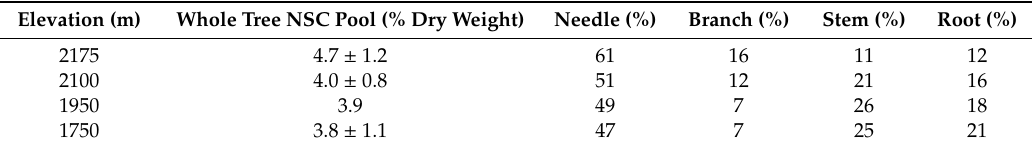
Table 2. Growing season mean whole tree non-structural carbohydrate (NSC) pools (% dry matter) and the contribution of needle, branch, stem, and root NSC accumulation patterns (%) to whole tree NSC pools of Pinus cembra trees along an altitudinal transect between 1750 and 2175 m a.s.l. on Mount Patscherkofel. After